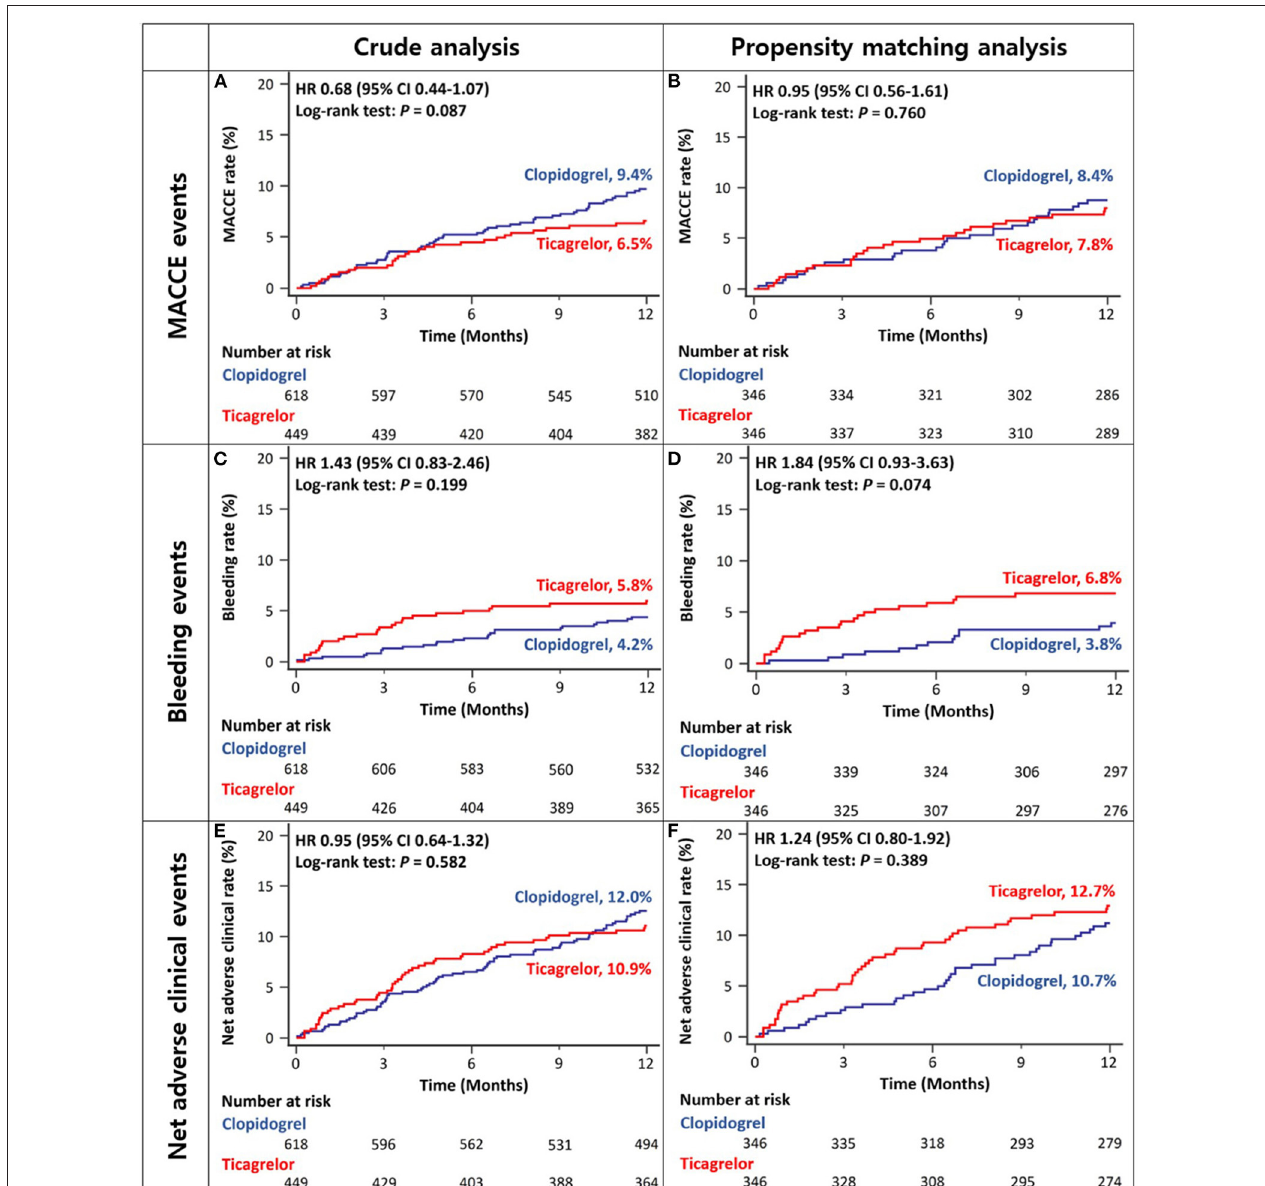
FIGURE 3 | Twelve-month cumulative incidence of major adverse cardiac and cerebrovascular events (A,B) , bleeding (C,D) , or net adverse clinical (E,F) events among acute coronary syndrome patients with CKD in crude (A,C,E) and propensity-score matched analyses (B,D,F) . MACCE, Major Adverse Cardiac and Cerebrovascular Event; CKD, Chronic Kidney